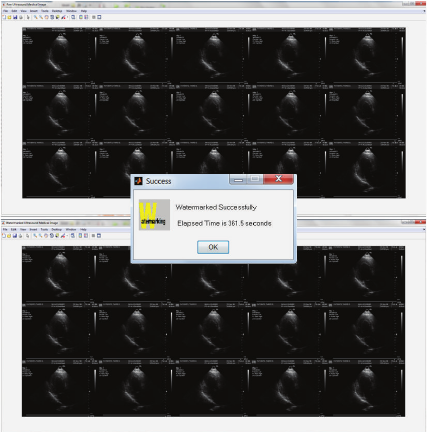
Figure 9: The output of raw and watermarked ultrasound medical images after a sequential watermarking embedding process.